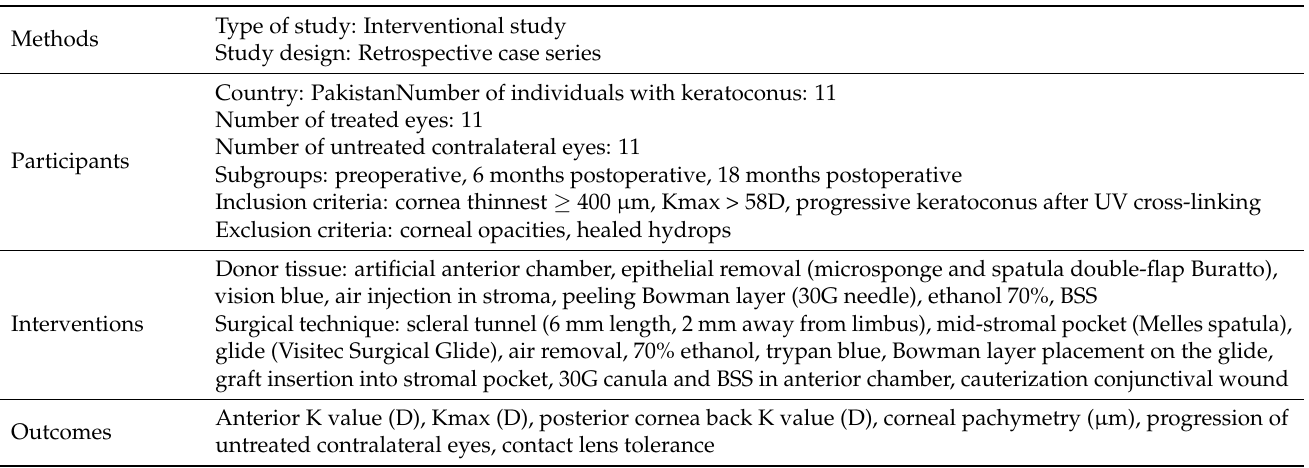
Table A7. Shah 2022 [35].